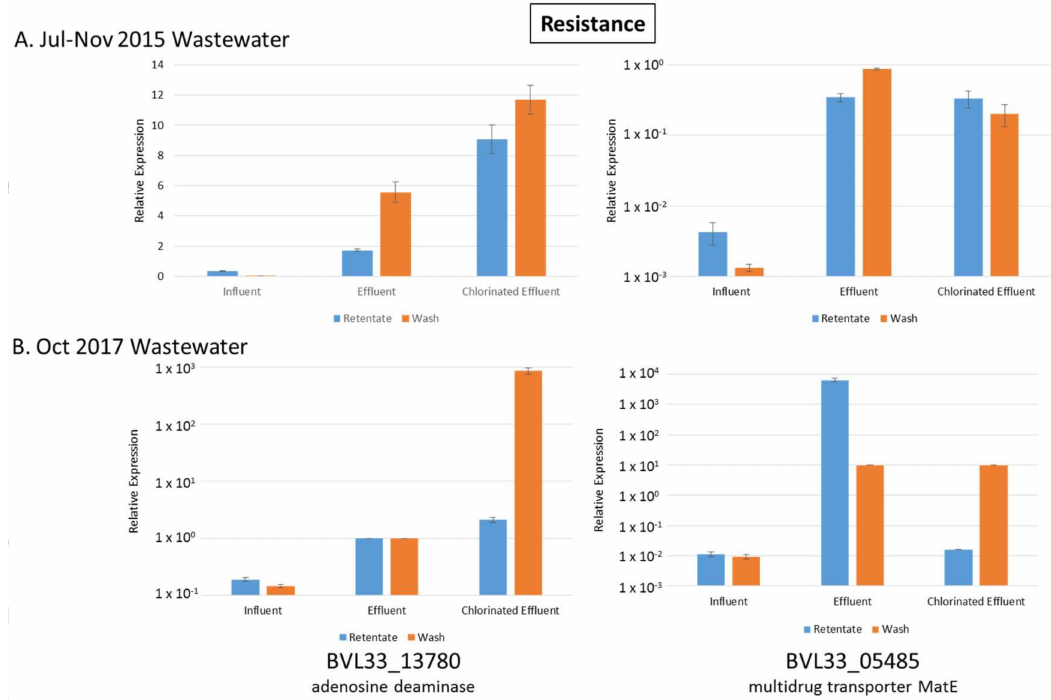
Figure 3. Relative expression profiles of A. junii genes involved in resistance. These genes displayed >2-fold change on RNA-seq analysis of wastewater sampled in July–November 2015 (Table 1). Gene expression values were normalized against a housekeeping rpoB gene. ( A ) Wastewater sampled in July, October and November of 2015; and ( B ) wastewater sampled in October